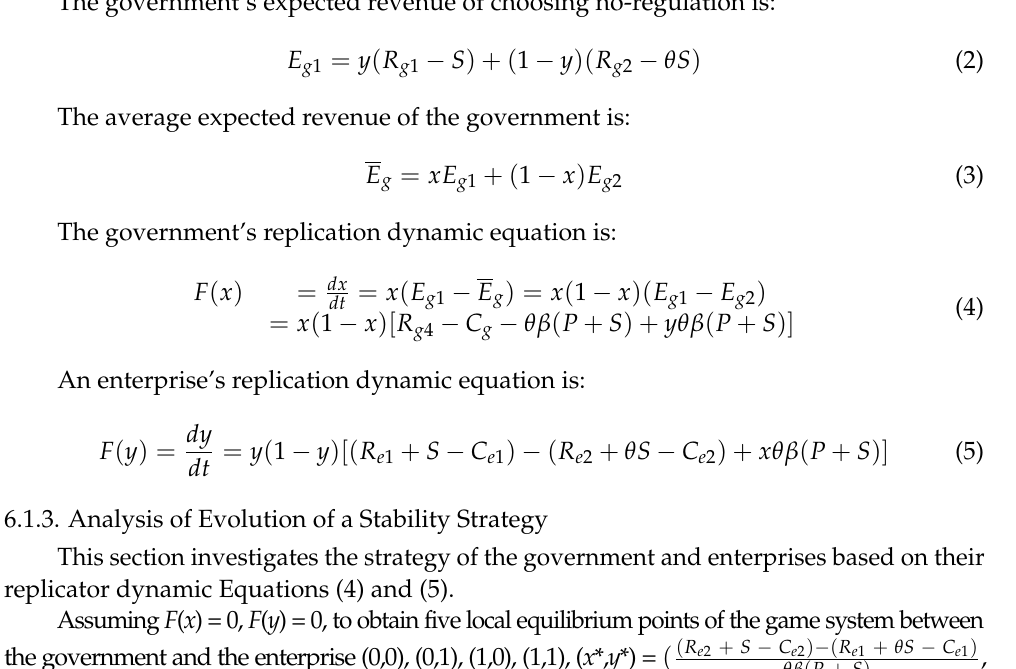
Table 6. Equilibrium point and stable conditions of the game system between the government and enterprises. Equilibrium Po int TrJ DetJ Stable Condition Results Stability Strategy